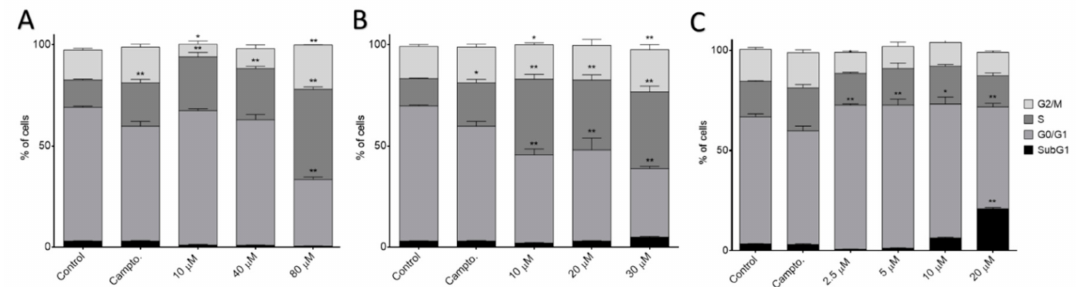
Figure 6. Cell cycle phase distribution of MCF-7 cell cultures after 24 h of treatment with different doses of I.1f ( A ), I.2f ( B ) and II.2d ( C ). * Statistical significance with values of p < 0.05; ** statistical significance with values of p <